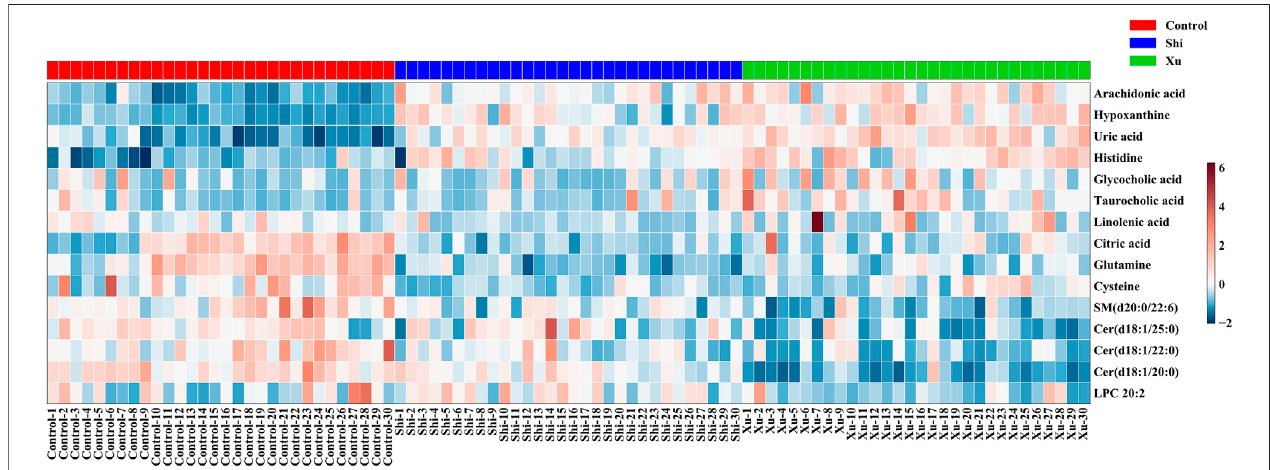
FIGURE 3 | Metabolites whose levels were signi fi cantly different between groups were organized into a heat map, with red and blue corresponding to increased and decreased levels, respectively. There are seven metabolites, i.e., Linolenic acid, Citric acid, Uric acid, Taurocholic acid, Hypoxanthine, Arachidonic acid, and Glycocholic acid coming from the data set of unbiased analysis using UPLC-qTOF-MS, the nontargeted metabolomics study. There were eight metabolites, i.e.,Histidine,Cysteine,Glutamine,LPC(20:2),Cer(d18:1/20:0),Cer(d18:2/22:0),Cer(d18:1/25:0),andSM(d20:0/22:6)comingfromthedatasetofthetargeted metabolomics study using QqQ-MS.